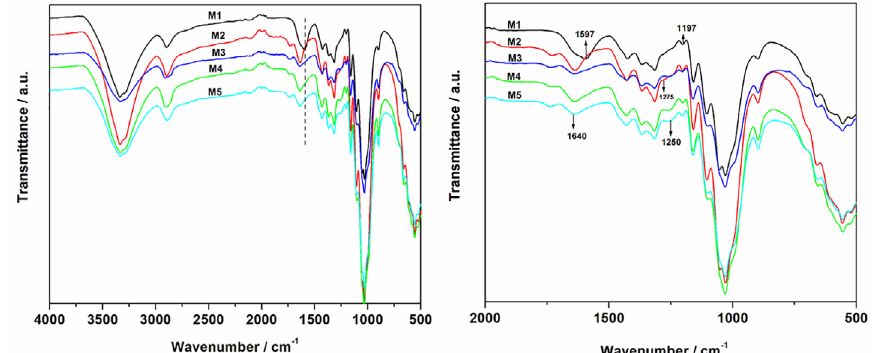
Figure 6. FTIR spectra of the methods used for the extraction of cellulose from sugarcane